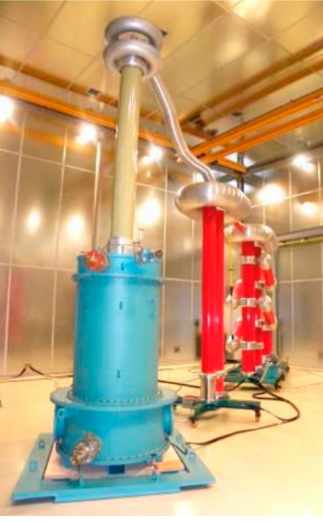
Figure 1. Ester filled HVDC demonstrator in the electrical research Laboratory at Siemens Transformers in Nürnberg, Germany [6].